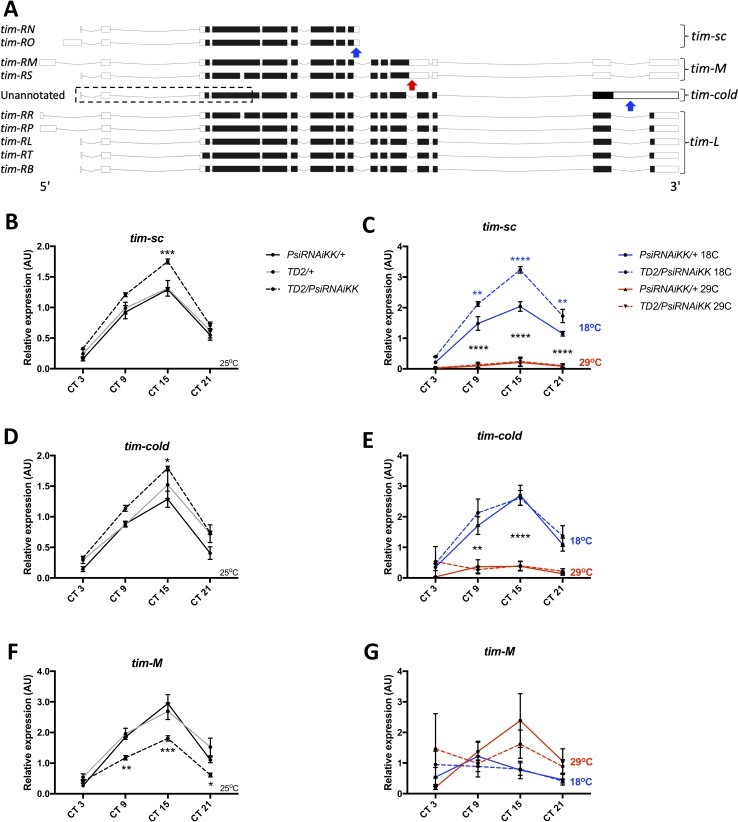
Knockdown of Psi increases the expression of cold induced tim isoforms and decreases the expression of a warm induced tim isoform.(A) Schematic of tim isoforms. Flybase transcript nomenclature on left, intron retention events studied here on right (tim-L refers to tim transcripts that do not produce C-terminal truncations of TIM via intron retention). Arrows indicate the location of retained introns: blue, upregulated at cold temperature; red, upregulated at warm temperature. The retained intron that gives rise to the tim-cold isoform is not annotated in Flybase (Thurmond et al., 2019). It is possible that multiple tim-cold transcripts may exist due to alternative splicing and alternative transcription/translation start sites in the 5’ region of the gene (dashed box). However, for simplicity, we depict this region of tim-cold using the most common exons. Adapted from Ensembl 94 (Zerbino et al., 2018). (B, D, F) Relative expression of tim mRNA isoforms at 25°C (normalized to the average of all Psi knockdown time points) in heads on the y axis measured by qPCR. Circadian time (CT) on the x axis. Error bars represent SEM. Gray line: driver control. Black line: RNAi control. Dashed line: Psi knockdown. Controls, N = 3. Psi knockdown, N = 5 (3 technical replicates per sample). Both driver and RNAi control compared to Psi knockdown, two-way ANOVA followed by Tukey’s multiple comparison test: *p<0.05, **p<0.01, ***p<0.001, ****p<0.0001. (C, E, G) Relative expression of tim mRNA isoforms at 18°C and 29°C (normalized to the average of all Psi knockdown time points). Solid line: RNAi control. Dashed line: Psi RNAi knockdown. Blue indicates flies were transferred to 18°C at CT0 (start of subjective day) on the first day of DD. Red indicates flies were transferred to 29°C. N = 3 (3 technical replicates per sample). 18°C samples compared to 29°C samples, *p<0.05, **p<0.01, ***p<0.001, ****p<0.0001, two-way ANOVA followed by Tukey’s multiple comparison test. (C) Blue asterisks refer to RNAi control compared to Psi knockdown.Figure 3—source data 1.tim qPCR data.Figure 3—source data 2.Figure statistics – Figure 3.